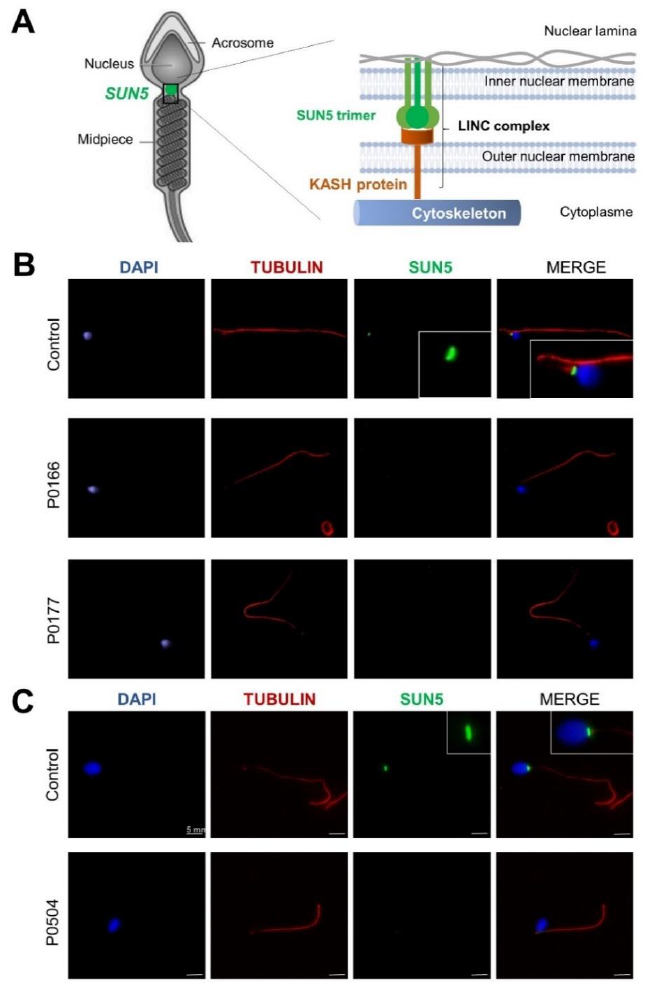
Figure 2. Localization of SUN5 and immunostaining in human spermatozoa from control and mutated subjects. ( A ) Localization of the SUN5 protein at the base of the sperm head, where it functions to anchor the sperm head to the flagellum. ( B , C ) Sperm cells from mutated subjects P0166 and P0177 ( B ) and P0504 ( C ) in addition to those from fertile controls were stained with anti-SUN5 (1:200, green) and anti-acetylated tubulin (1:2000, red) antibodies. DNA was counterstained with 4′,6-diamidino-2-phenylindole (DAPI), showing sperm nuclear DNA (blue). The SUN5 immunostaining (green) marked a punctiform signal at the head–tail junction. The co-staining with alpha-tubulin, specific for the flagella, confirm the localization. In contrast, the SUN5 signal is absent from P0166, P0177, and P0504, confirming the deleterious effect of the mutation. KASH: Klarsicht, ANC-1, Syne Homology; LINC: linker of nucleoskeleton and